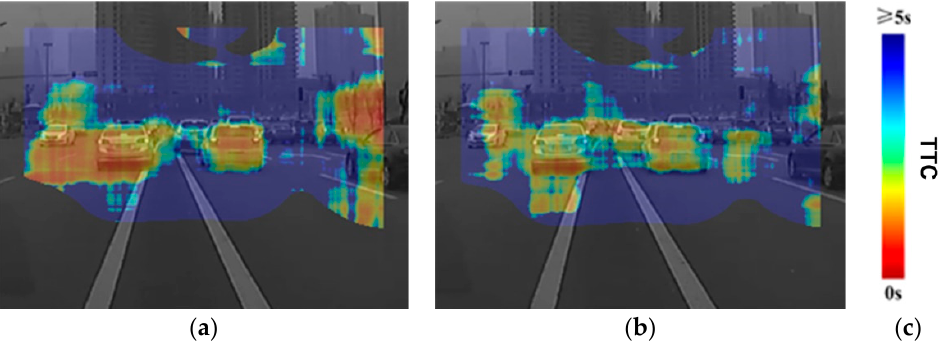
Figure 6. The TTC map sequence for a real-world driving video clip, overlaid on the image frames. The video was captured with a dashboard camera from a car, initially moving at a velocity of about 20 km/h and then decelerating and coming to a complete halt. Colors trending toward red show shorter TTC values, whereas those trending toward blue show longer TTC values. TTC values longer than 5 s are shown as blue. ( a ) far from the observing car. ( b ) a little closer to the observing car at slightly decelerated velocity. ( c ) legend bar for TTC heat map values.